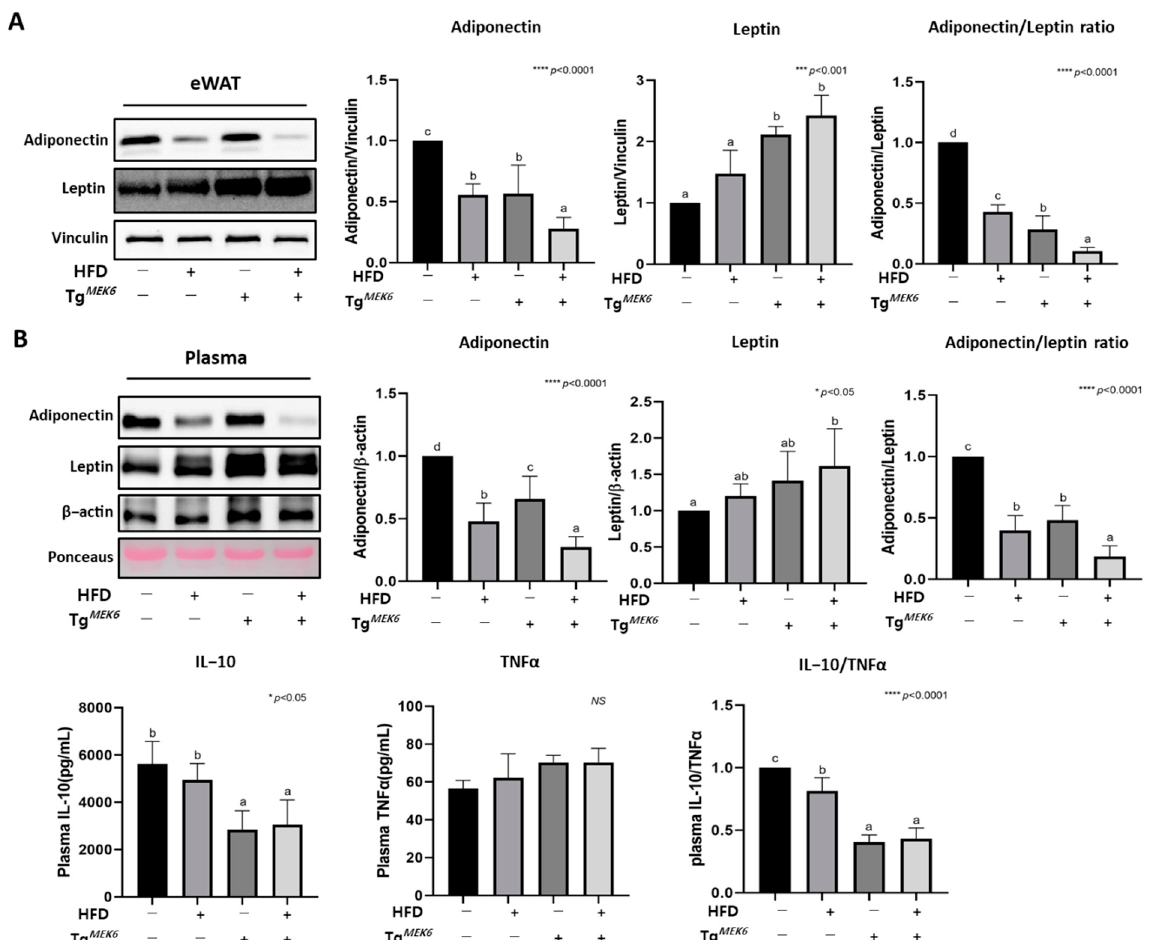
Figure 6. Effects of MEK6 overexpression on the cytokines of WAT and plasma. ( A ) The expression of proteins related to adipokines (adiponectin, leptin) and adiponectin/leptin ratio were measured by western blotting in eWAT. ( B ) The ex ‐ pression of proteins related to adipokines (adiponectin, leptin) and adiponectin/leptin ratio and cytokine levels such as IL ‐ 10(anti ‐ inflammatory), TNF α (pro ‐ inflammatory) and IL ‐ 10/TNF α were measured by western blotting or ELISA in plasma. Results are expressed as mean ± SD. Data were assessed by one ‐ way ANOVA with Duncan’s test (NS, not signif ‐ icant by unpaired t ‐ test. *; p < 0.05, ***; p < 0.001, ****; p < 0.0001). Superscript letters (a–d) indicate the significant differences between the groups at p < 0.05. +, treatment or transfection; − , non ‐ treatment or non ‐ transfection.